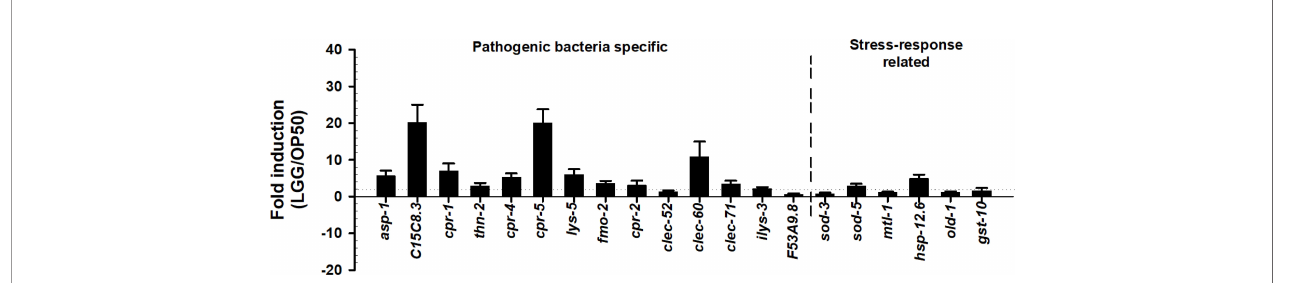
FIGURE 3 | The alteration of the transcription of immune and stress related genes. Expression levels (LGG/OP50, normalized fold changes assessed by qRT-PCR analysis) of fourteen pathogenic bacteria speci fi c immune response ( asp-1, C15C8.3, cpr-1, thn-2, cpr-4, lys-5, fmo-2, cpr-2, clec-52, clec-60, clec-71, ilys-3, F53A9.8 ) and six stress response related genes ( sod-3, sod-5, mtl-1, hsp-12.6, old-1, gst-10 ) in C. elegans . The dotted line shows 2-fold changes in LGG-induced gene expression compared to that of OP50-induced